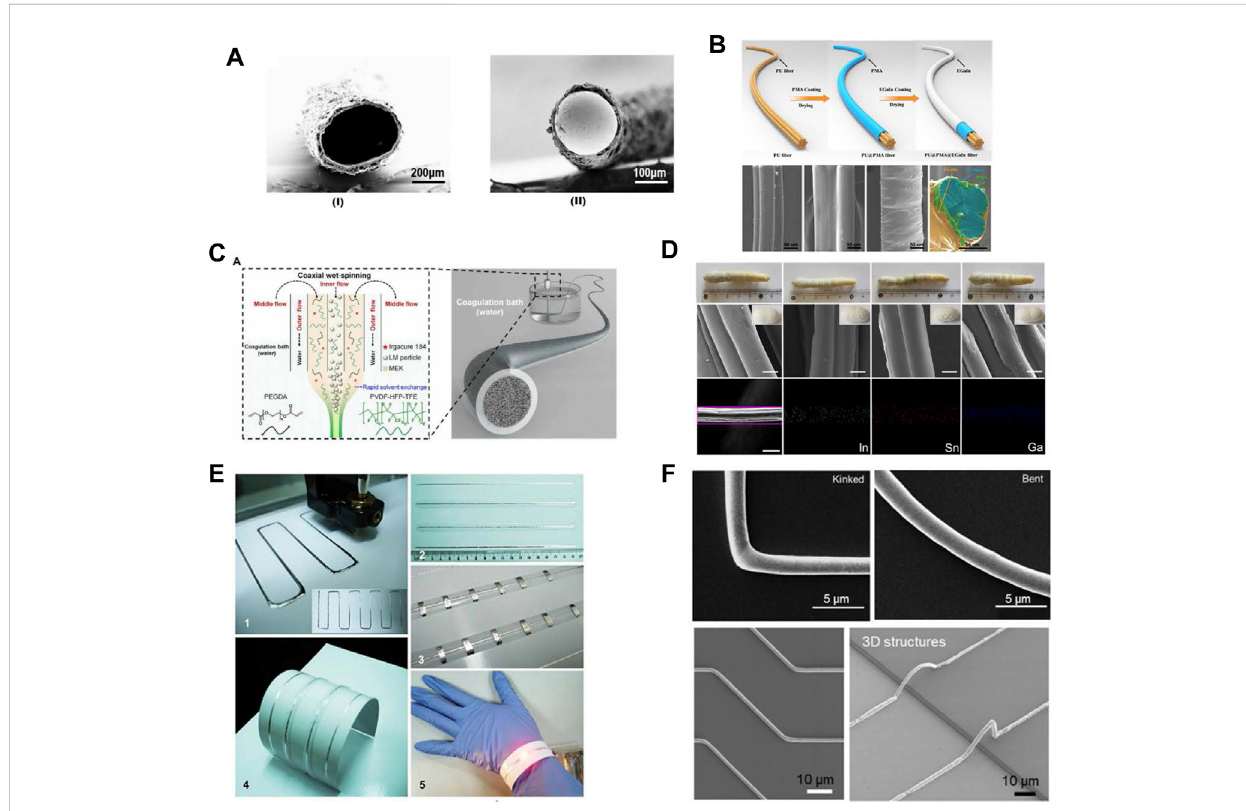
FIGURE 5 Manufacturing of liquid metal fi bers. (A) Hollow fi ber and injected liquid metal enter hollow fi ber to produce liquid metal fi ber (YU et al., 2020) (B) Schematic for the preparation of LM-coated fi ber (CHEN et al., 2020b) (C) Schematic diagram of making core-shell liquid metal fi ber by electrospinning (ZHENGetal., 2021) (D) Liquid metal feeding silkwormto obtainliquid metal fi ber(GAO etal., 2022) (E) Schematicdiagram of liquid metal fi ber produced by 3D printing (ZHENG et al., 2013) (F) SEM of liquid metal fi ber with 3D structure (PARK et al.,